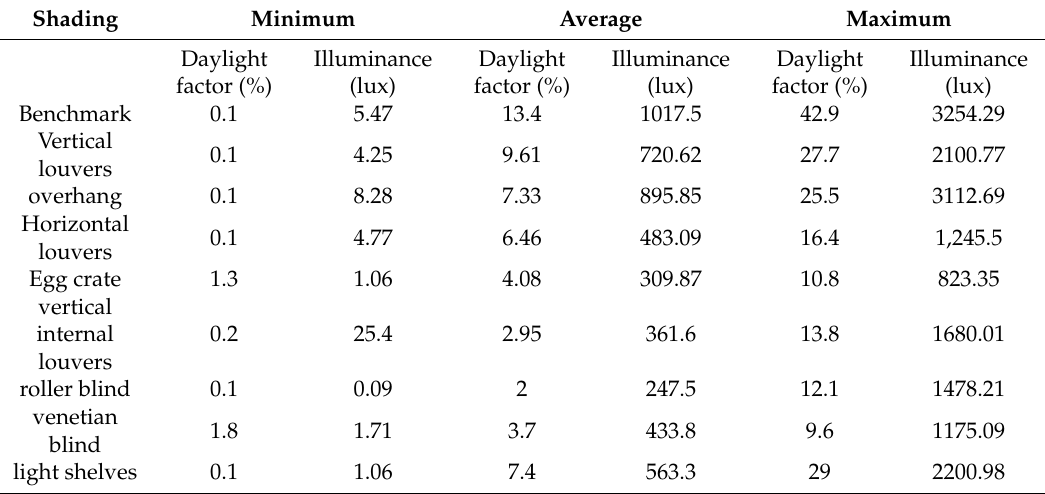
Table 11. Minimum, average and maximum daylight factor and illuminance level for each